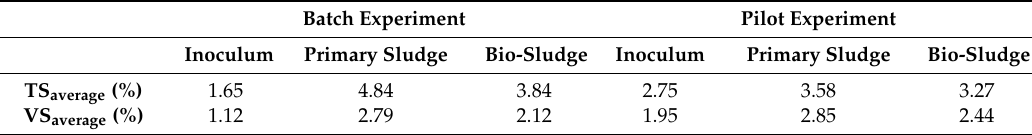
Table 2. The characteristics of the inoculum and the feed sludge used in the batch and pilot